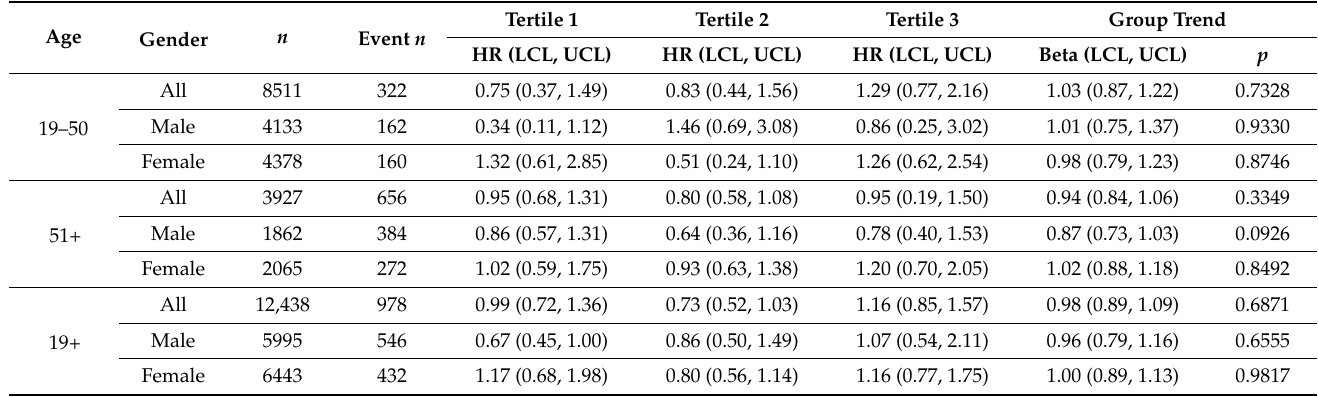
Table 6. Cancer mortality hazard ratio associations with low-calorie sweeteners, 1988–1994. Data are hazard ratios (HR) and 95th percentile confidence lower (LCL) and upper (UCL) levels. Cox proportional hazards regression was used to estimate HR and 95th percentile confidence levels for cancer mortality. HRs were estimated by assigning nonconsumers of aspartame/saccharin/LCS to the reference group (HR = 1.0). LCS consumers were then split by tertiles of consumption T1, T2, and T3, using SAS 9.4 PROC SURVEYPHREG with age, sex, race/ethnicity, education, current smoking status (Y/N), alcohol consumption, physical activity level, and BMI (continuous) as covariates. Data adjusted for complex sample design of NHANES and used relevant sample weights.